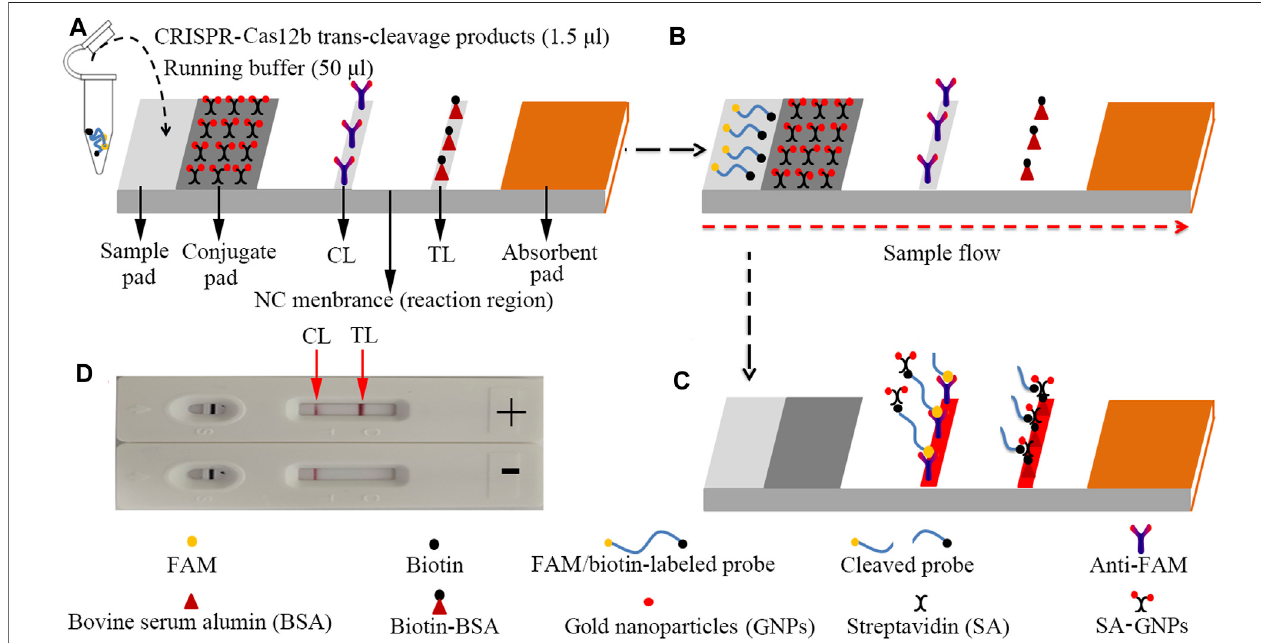
FIGURE 3 | The schematic of the LFB for visualization of HBV genotype B and C products. (A) The reaction mixtures (1.5 μ l) and the running buffer (50 μ l) were deposited on the sample pad. (B) The running buffer containing mixtures moved along the LFB owing to capillary action; meanwhile, the dye and streptavidin-coated gold nanoparticles (GNPs) rehydrated intheconjugate region. (C) In thepositivesample,thessDNAreportermolecule (5 ′ -FAM-TTTTTT-Biotin-3 ′ )was trans -cleaved by theactivatedCRISPR-Cas12bnucleaseandtheFAMandbiotinwereseparated.Hence,thebiotin – streptavidin – GNPscomplexwascapturedbybiotin-BSAatthe TL; however, in negative outcomes, the ssDNA reporter molecule was not cleaved and was speci fi cally captured by the anti-FAM at the CL. The biotins of the ssDNA reporter molecule bind streptavidin – GNPs for visualization at the CL. (D) Interpretation of the CRISPR-HBV assay results. For positive results, the CL and TL appear on the LFB. When only the CL is observed on the LFB, it indicates negative outcomes. CL: control line; TL: test